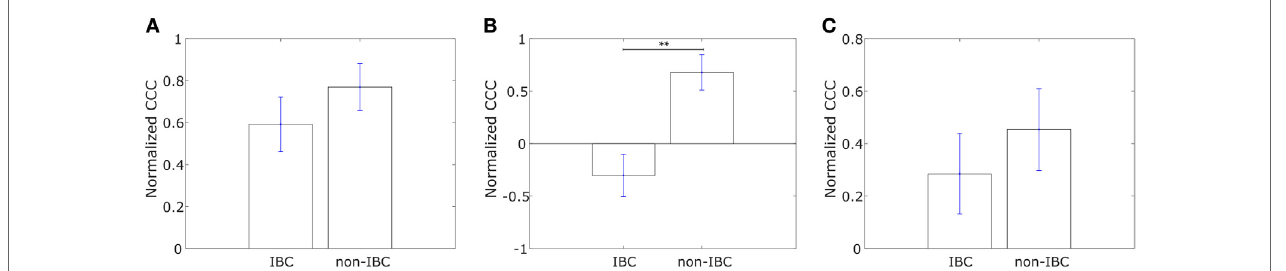
FigUre 5 | Normalized cophenetic correlation coefficient of canonical epithelial-to-mesenchymal transition driving transcription factors for tumor samples from inflammatory breast cancer (IBC) patients and non-IBC breast cancer patients for data from studies by (a) Iwamoto et al. (45) with 25 IBC and 57 non-IBC breast cancer patients, (B) Boersma et al. (46) with 13 IBC and 35 non-IBC breast cancer patients, and (c) Woodward et al. (24) with 20 IBC and 20 non-IBC breast cancer patients. Error bars indicate the SE in the estimate of CCC norm calculated using the bootstrap method. ** p -Value <